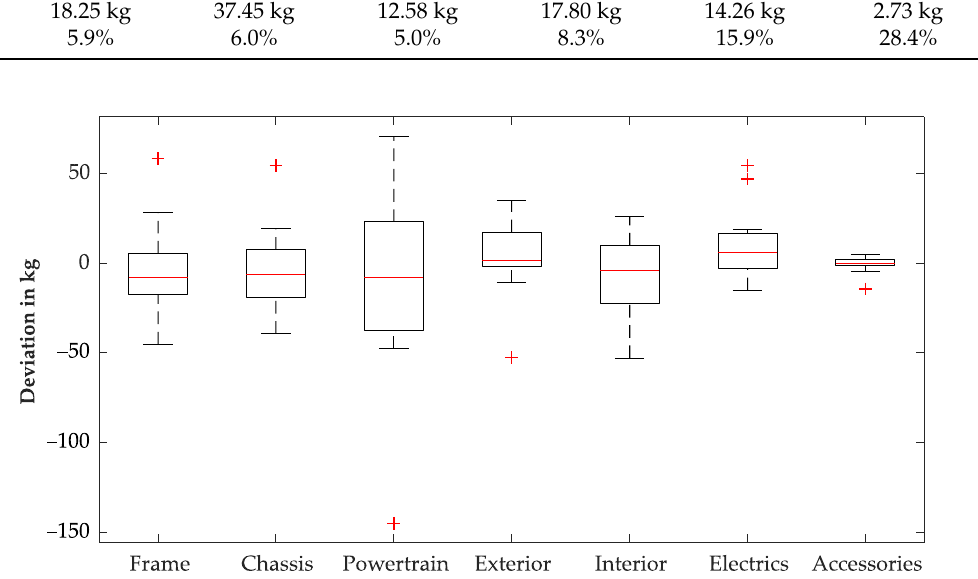
Figure 5. Boxplot showing the difference between calculated and real module masses.